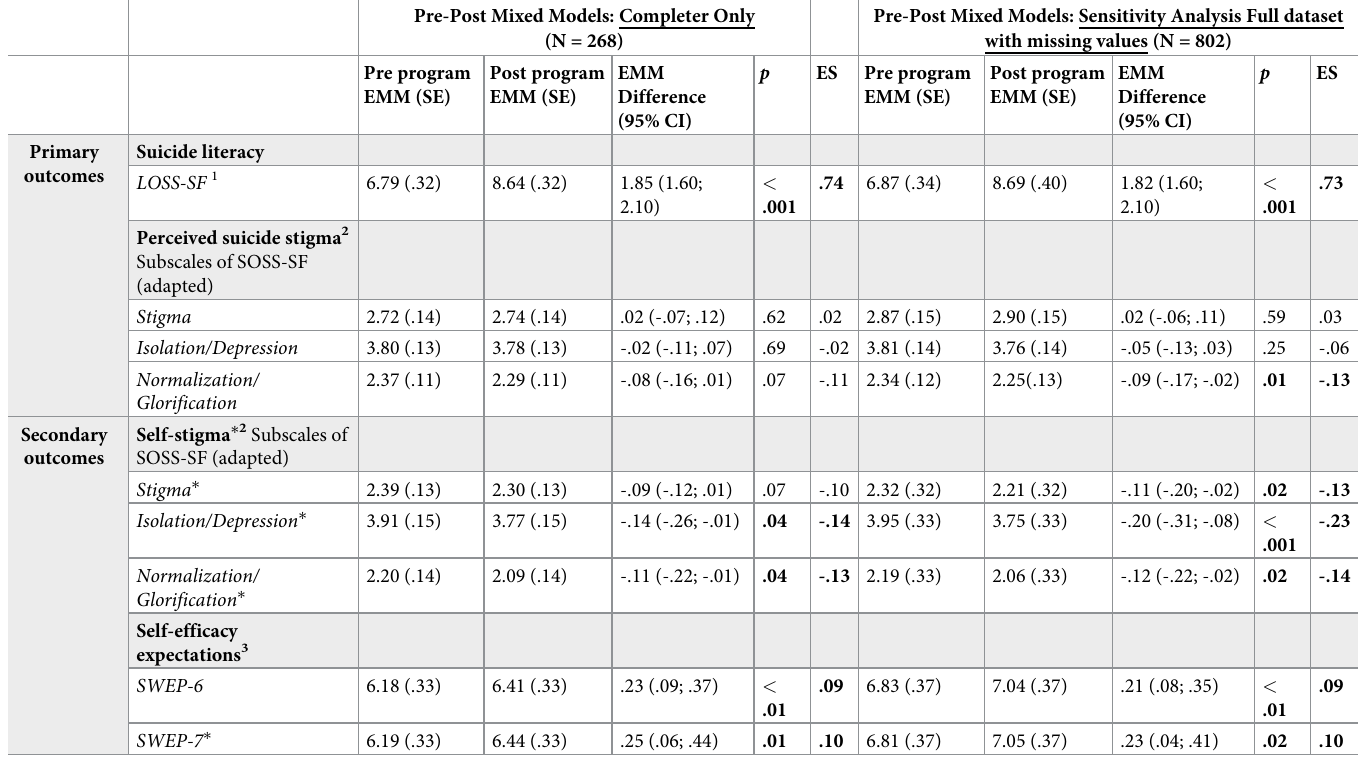
Table 2. Pre-post comparison in primary and secondary outcomes.